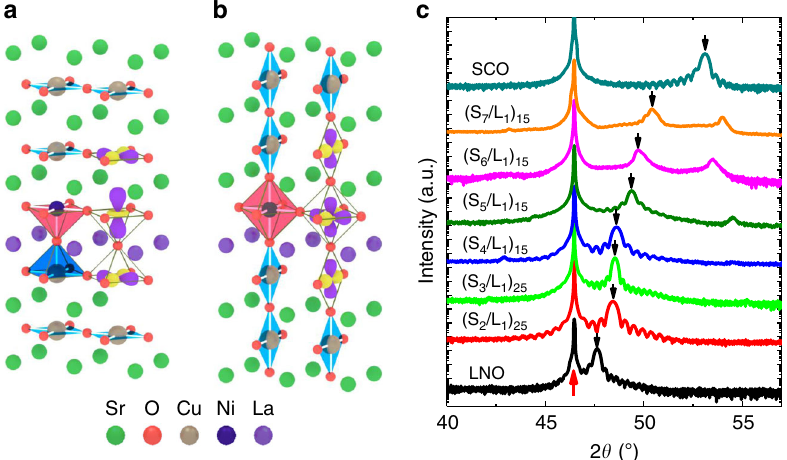
Fig. 1 Interfacial engineering of oxygen coordination in SrCuO 2 /LaNiO 3 superlattices. Schematics for SrCuO 2 /LaNiO 3 (SCO/LNO) heterostructures with a planar-type SrCuO 2 and b chain-type SrCuO 2 , resulting in different oxygen coordination and orbital polarization of Ni ions in LaNiO 3 . c X-ray diffraction (XRD) θ – 2 θ scans of a LaNiO 3 fi lm (34 nm in thickness), ((SrCuO 2 ) N /(LaNiO 3 ) 1 ) M (noted as (S N /L 1 ) M ) superlattices, and a SrCuO 2 fi lm (28 nm). The red and black arrows indicate the SrTiO 3 002 peak and the peaks from superlattices or fi lms, respectively, showing a clear modulation of out-of-plane lattice